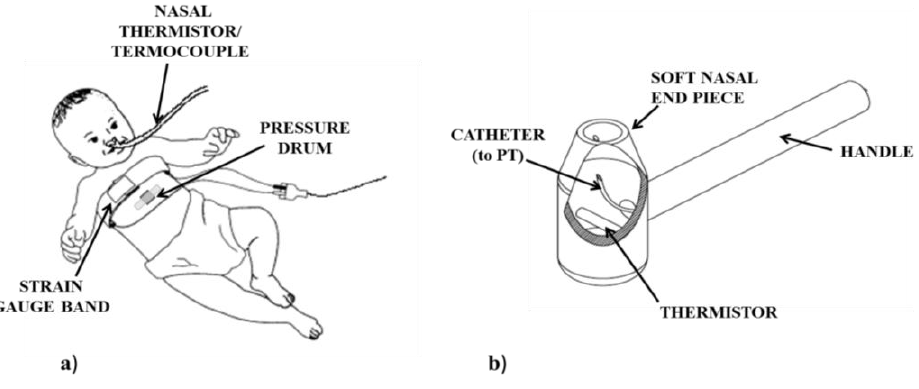
Figure 9. Devices used for breathing monitoring. ( a ) Nasal thermistor or thermocouple applied below the nostrils for nasal airflow measurement; pressure drum or strain gauge band on the chest for respiratory movements measurement; ( b ) Rigid tool applied into the nostrils: the thermistor and the PT are used respectively to assess air flow and its versus